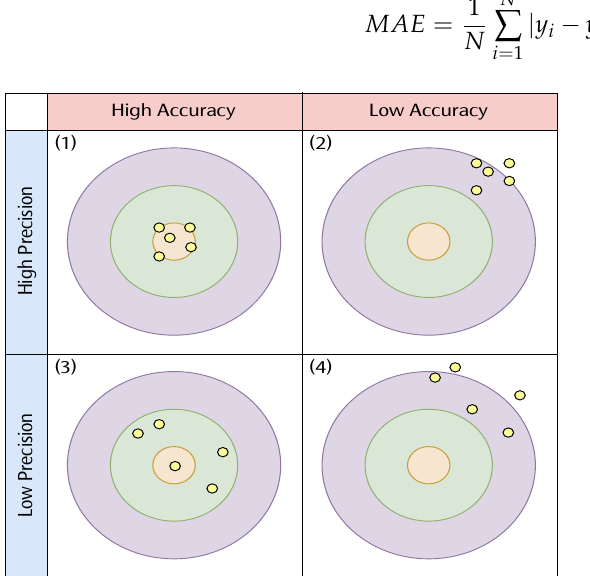
Figure 6. Performance evaluation criteria where yellow dots are the predicted values. (1) is high accuracy and high precision, which is the best scenario. (2) is low accuracy and high precision. (3) is high accuracy and low precision. (4) is low accuracy and low precision, which is the worst